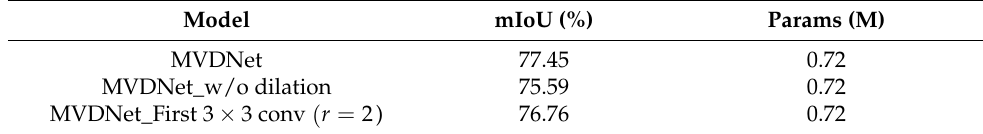
Table 7. Dilation of MVDNet effect on